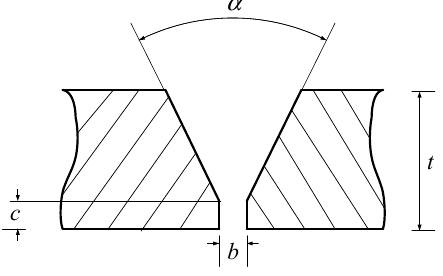
Figure 4. Groove design for butt welding samples.